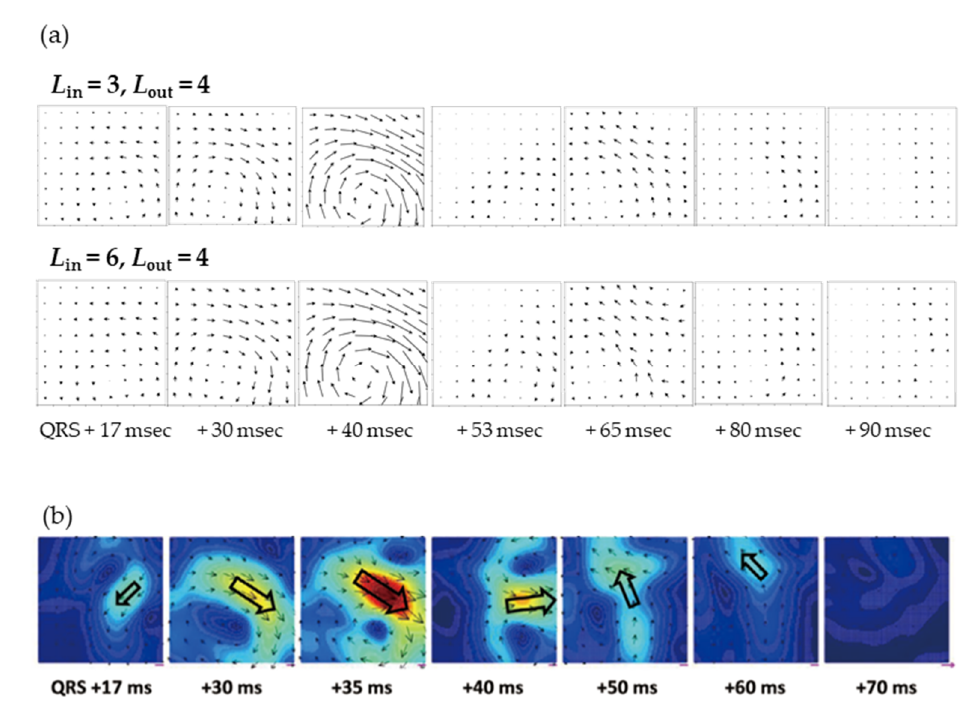
( b ) Magnetic field strength maps in contour lines and current arrow maps at peaks of R and T waves.